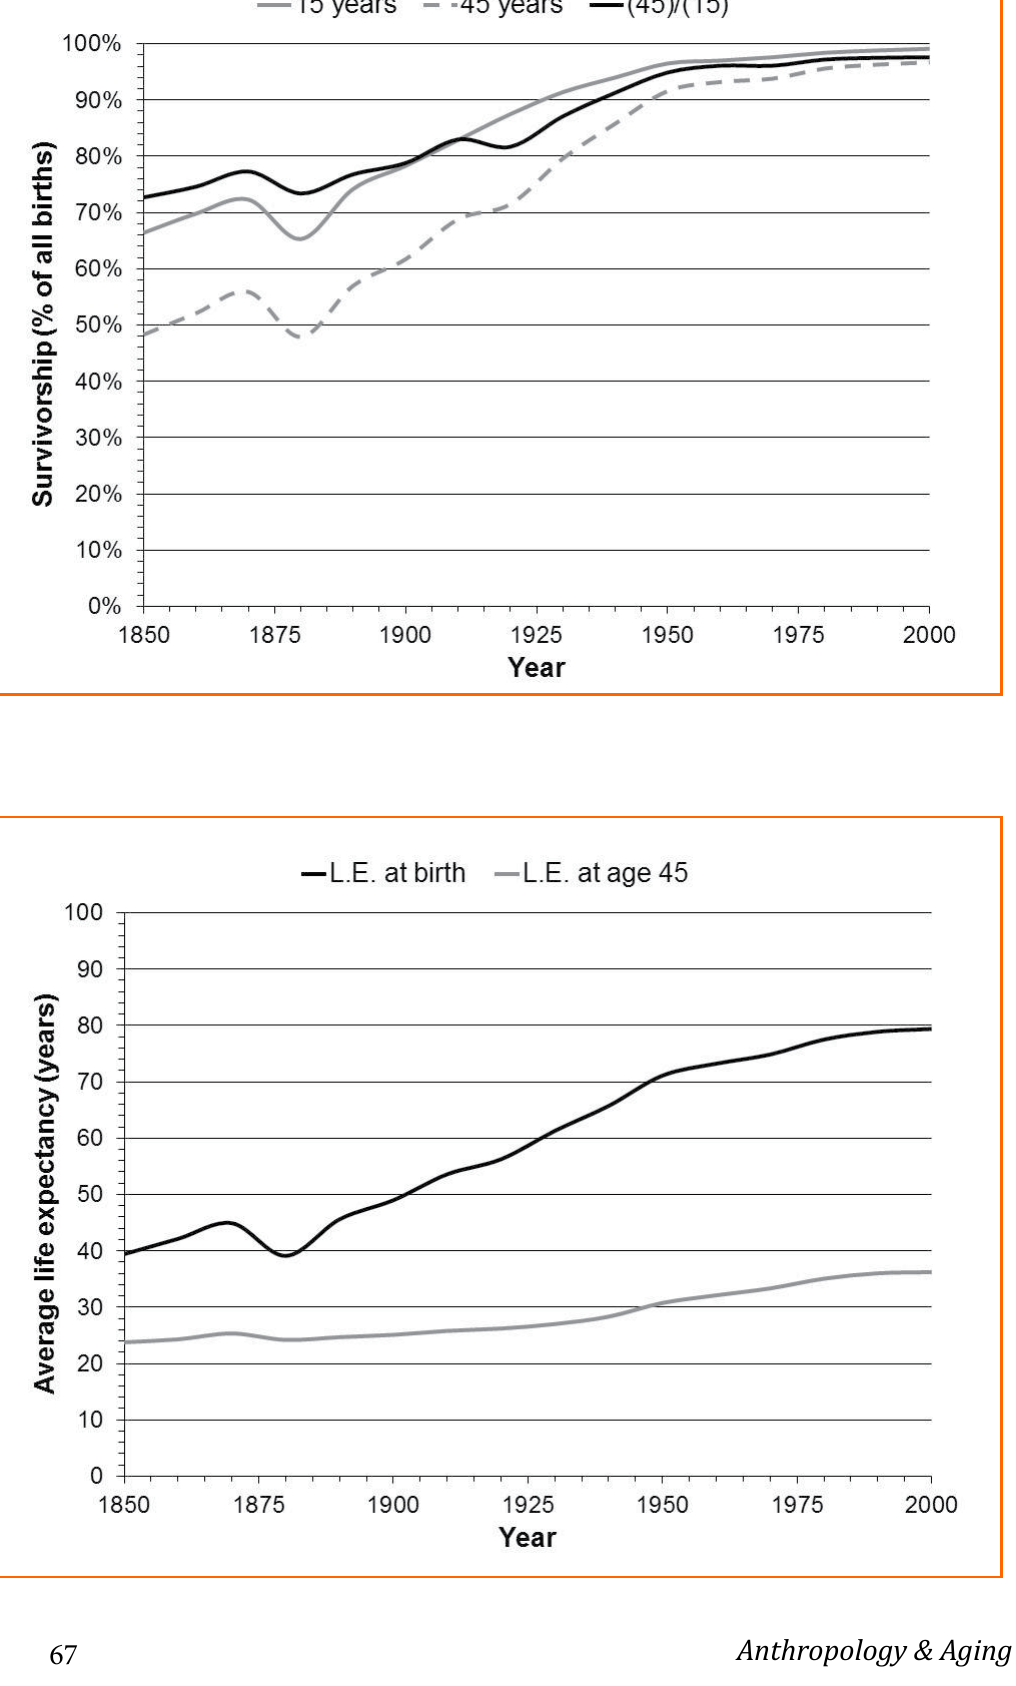
Figure 2: Survivorship from birth to age 15 years (solid gray line) and birth to age 45 years (dashed gray line); conditional survivorship from 15-45 years (black line: rate at which individuals who survived to age 15 also survived to age 45).